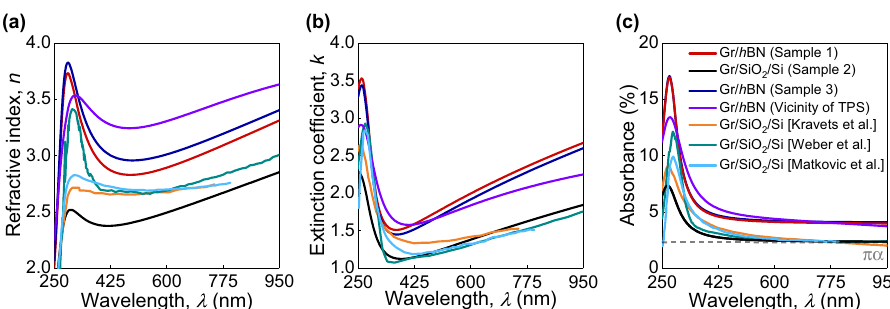
Fig. 4 Comparison of optical constants of exfoliated monolayer graphene on SiO 2 /Si and h BN substrates. a Refractive indices, b extinction coef fi cients, and c intrinsic absorbance A vs wavelength. A = 4 π nkt/ λ , where n is the refractive index, k is the extinction coef fi cient, t is the thickness of graphene, and λ is the wavelength